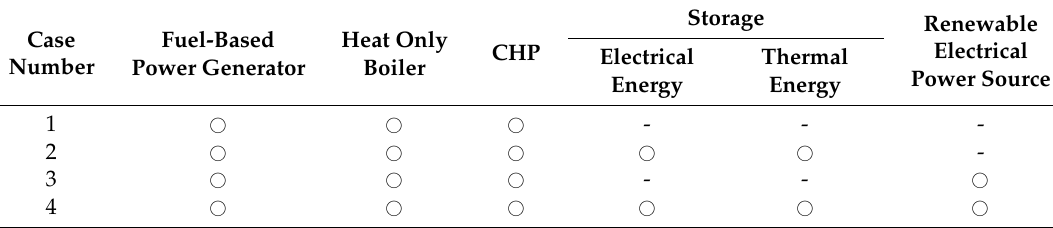
Table 5. Configurations of energy resources used in expansion planning.